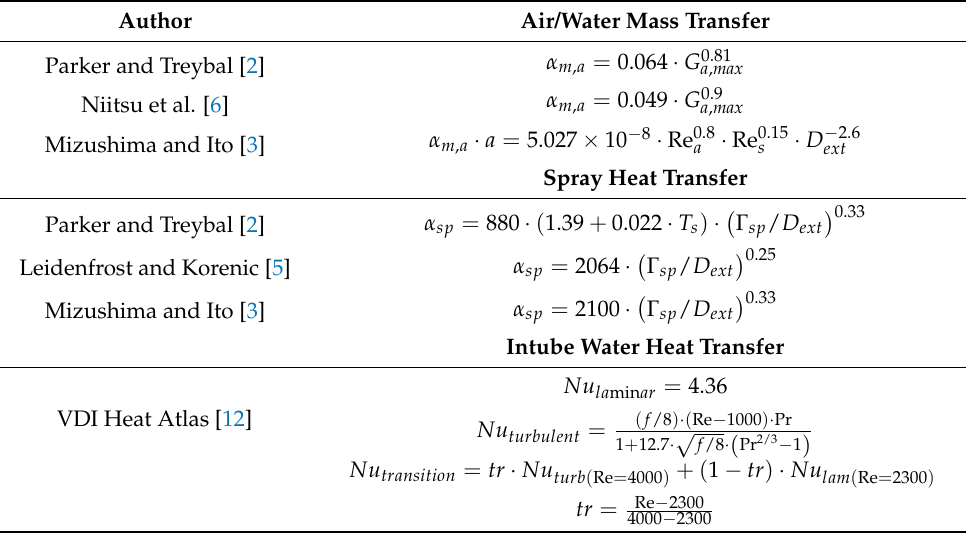
Table 2. Heat and mass transfer coefficients proposed in literature for evaporative cooling